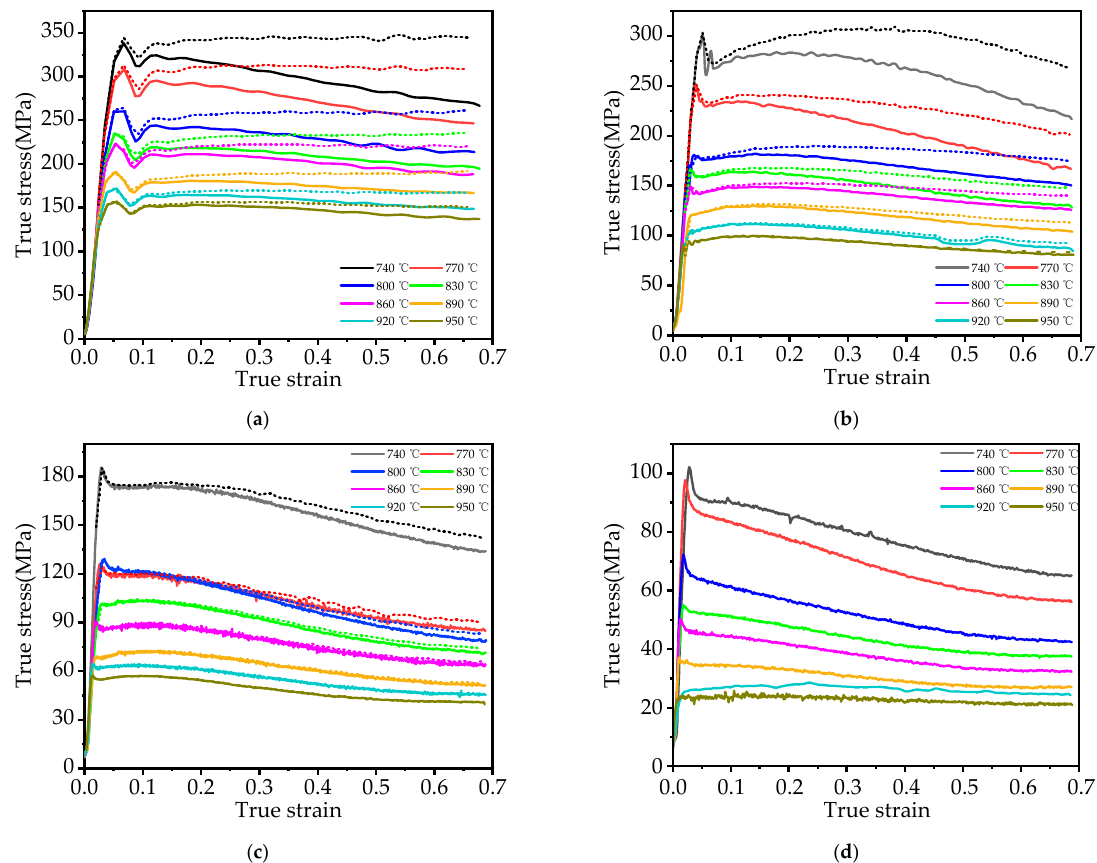
Figure 2. Stain − stress curves of Ti − 65541 under different strain rates: ( a ) 1 s − 1 , ( b ) 0.1 s − 1 , ( c ) 0.01 s − 1 , ( d ) 0.001 s − 1 .